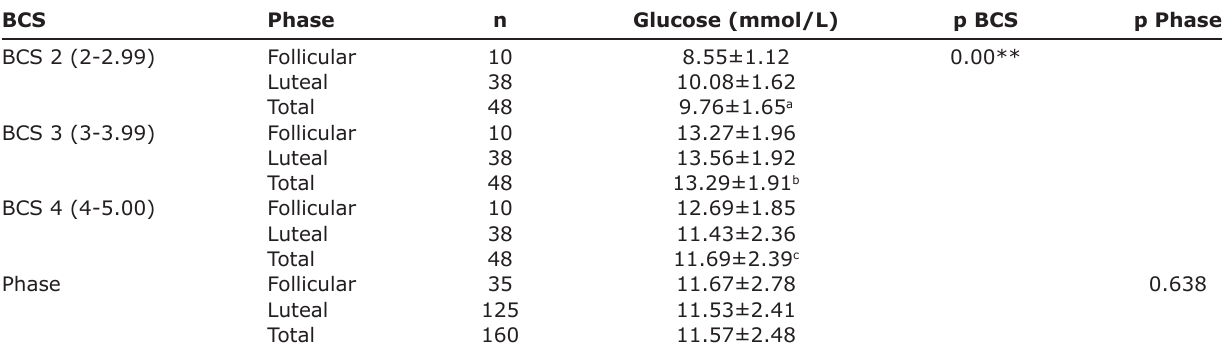
Table-2: Glucose levels of Saanen goats in each body condition score during the phases of estrous cycle (mean±SD).